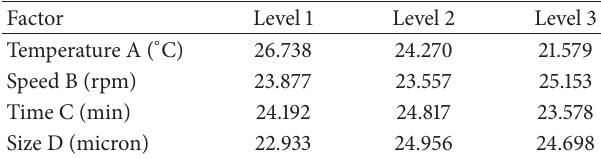
Table 6: Average of S / N